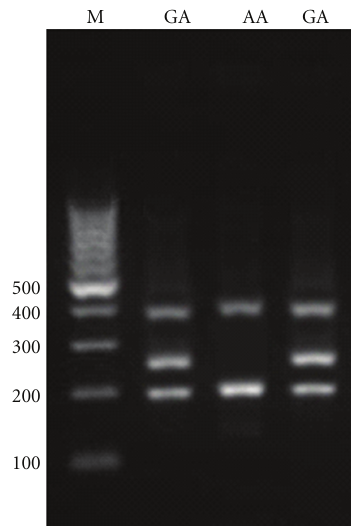
Figure 1: Electrophoresis pattern of tetra-amplification refractory mutation system-polymerase chain reaction (T-ARMS-PCR) for detection of SNP in IRGM − 1208 A/G. M : DNA marker. Product sizes were 195bp for A allele, 254 bp for G allele, and 402 bp for two outer primers (control band).